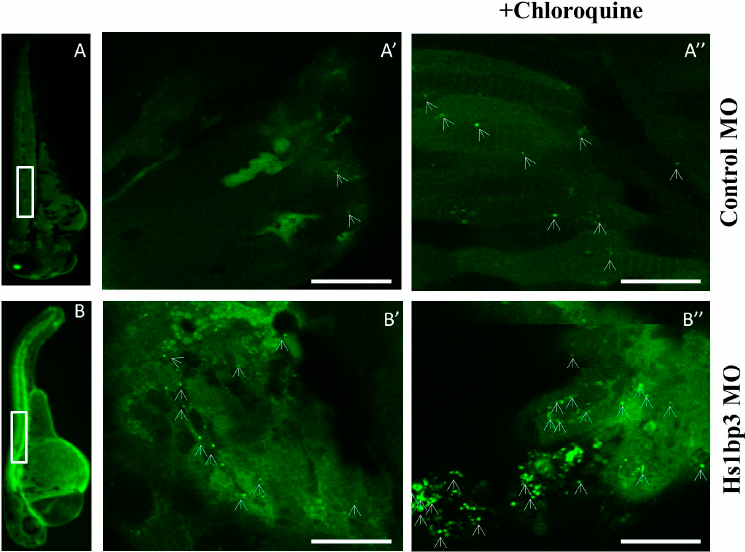
Figure 3. Confocal imaging of Tg(CMV:GFP-Lc3). Representative confocal images of GFP-Lc3 puncta (autophagosomes) in the trunk area of GFP-Lc3 transgenic zebrafish embryos injected with control morpholino or Hslbp3 translational-blocking morpholino and imaged at 2 days post fertilization (dpf) with or without pre-treatment with chloroquine (10 mM) for 6 h. Scale bars, 10 µM for the confocal images. Panel A, B shows the whole zebrafish larvae at 2 days post fertilization highlighting the trunk area chosen for confocal imaging; Panel A’, A’’, B’, B’’ shows respective confocal images.